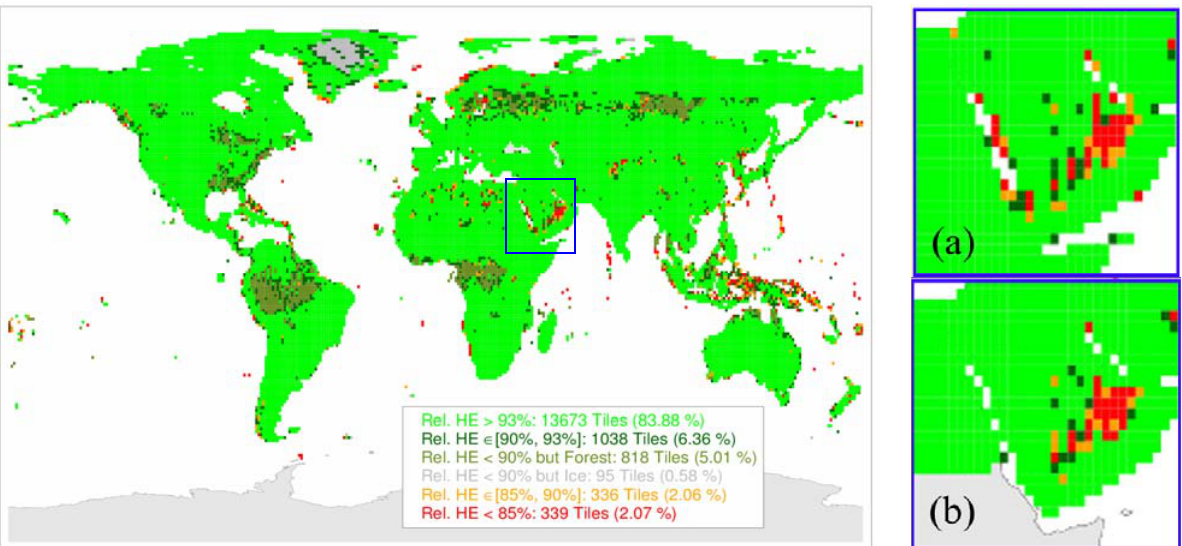
Figure 5. Confidence level of the relative height error for final DEM tiles, derived from the quicklook mosaic of the relative height error standard deviation. Subfigures (a) and (b) over the Arabian Peninsula present the confidence level per tile derived from the quicklook mosaic compared to the height error confidence level of the final TanDEM-X DEM at full resolution, respectively.